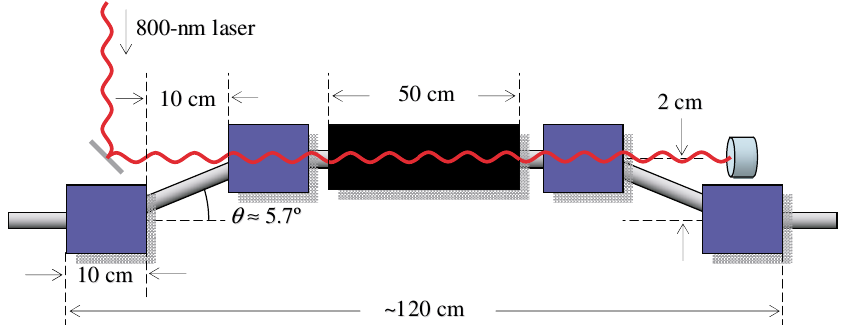
FIG. 14. (Color) Layout of the LCLS laser heater inside a magnetic chicane at 135 MeV.